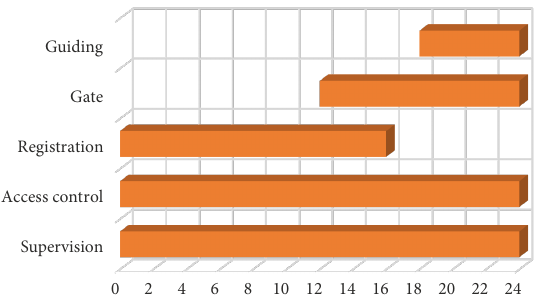
Figure 5. Activities within the flight (start and duration)